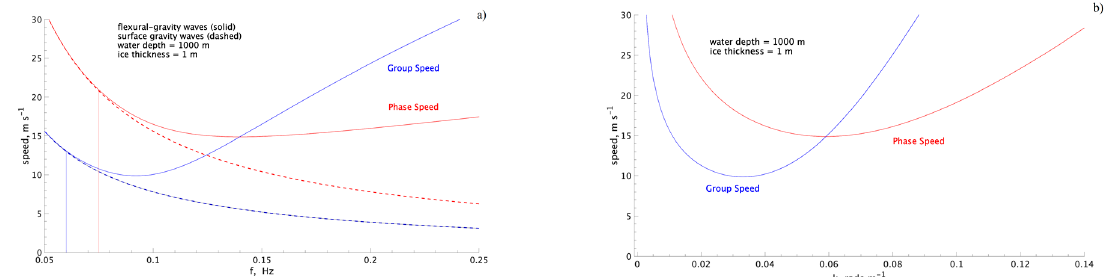
Figure 1. Phase (red) and group (blue) speeds for gravity waves (no ice, dashed lines) and flexural-gravity waves (1-m ice, solid lines) versus ( a ) frequency and ( b ) wavenumber. The group speeds begin to diverge above frequencies of ~0.06 Hz and the phase speeds begin to diverge above frequencies of ~0.075 Hz.